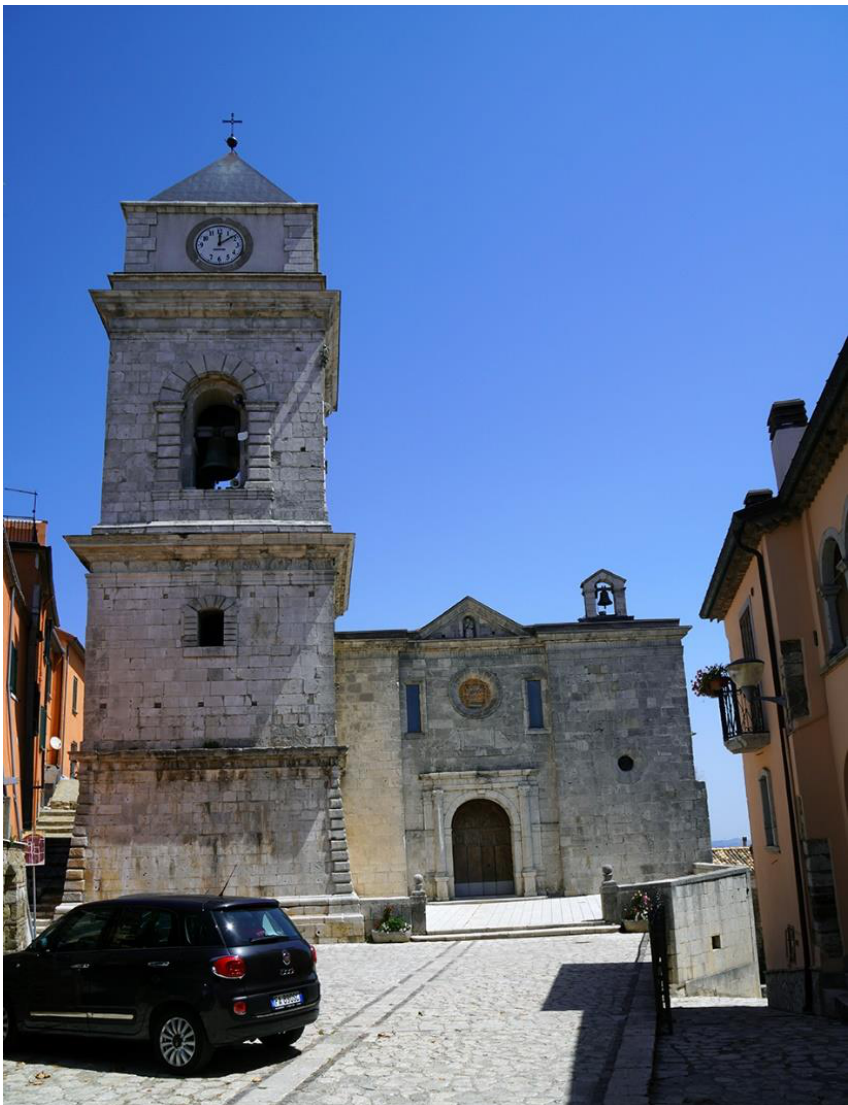
Figure 72. Guardia dei Lombardi: the restored Church of Santa Maria delle Grazie (photos by [35,36]).